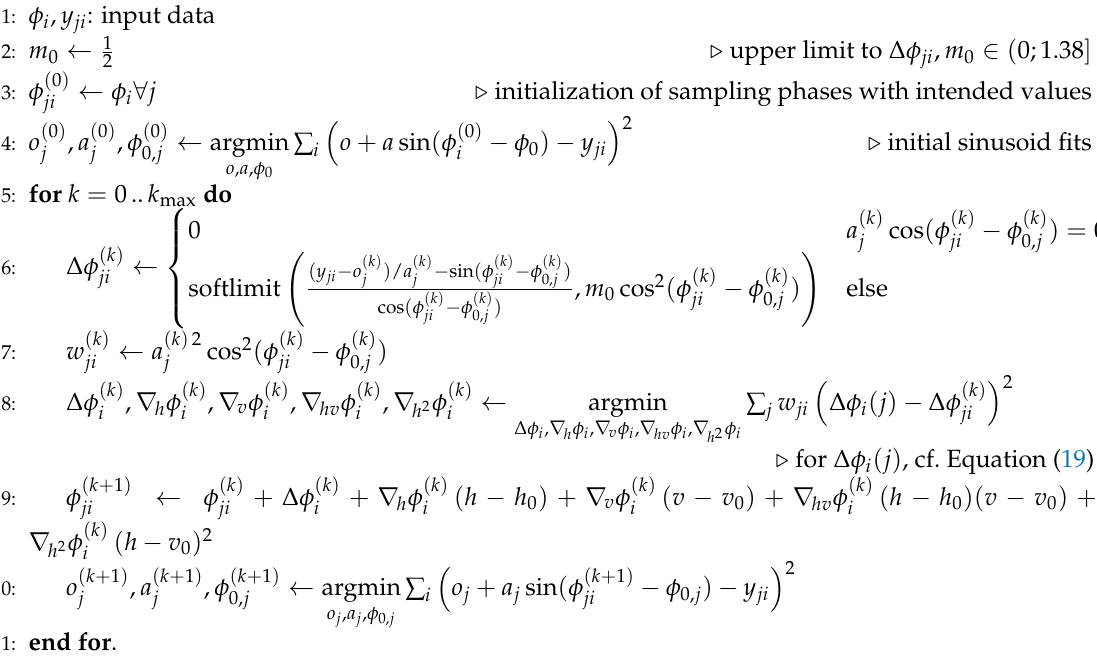
Algorithm 2 Simultaneous least squares optimization of abscissa values φ ji and sinusoid fits to ordinate samples y ji belonging to independent curves j sampled at positions φ ji = φ i ( j ) with φ i ( j ) being a slowly varying polynomial with respect to the spatial coordinates h ( j ) and v ( j ) accounting for the expected effects due to translations, magnification and rotations of an interferometer’s gratings. The procedure reduces to Algorithm 1 when considering only the zeroth order term of φ i ( j )